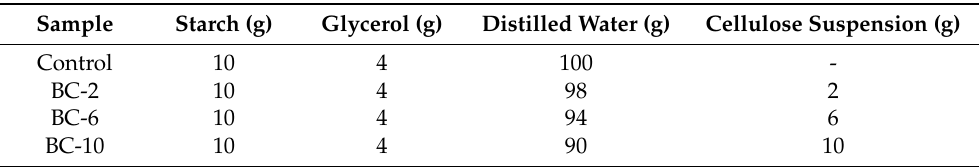
Table 1. Composition of starch and biocomposite